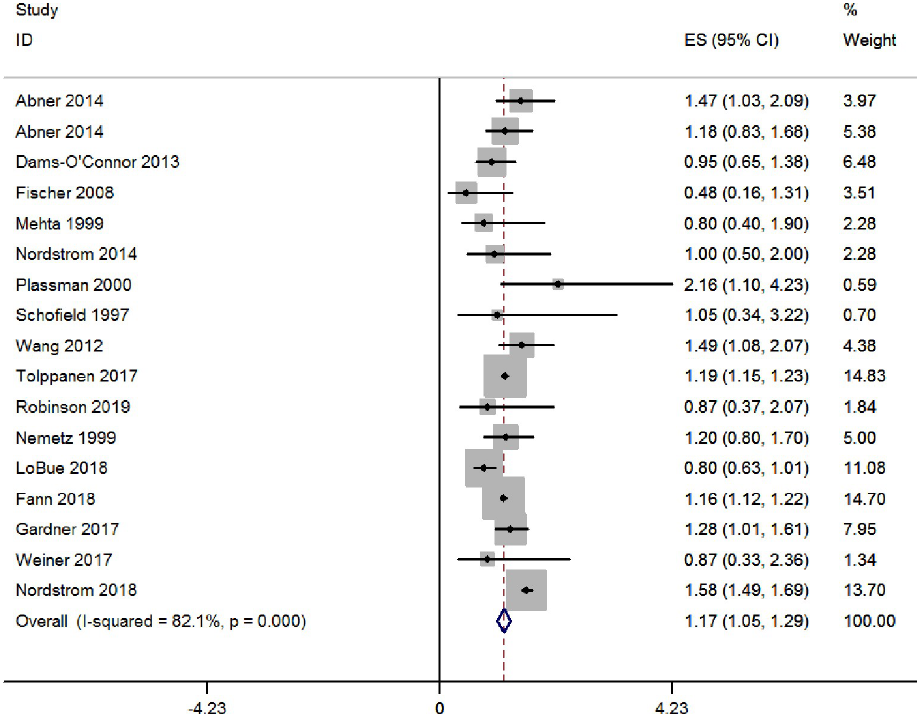
Fig 2. Forest plot of traumatic brain injury and the risk for AD.